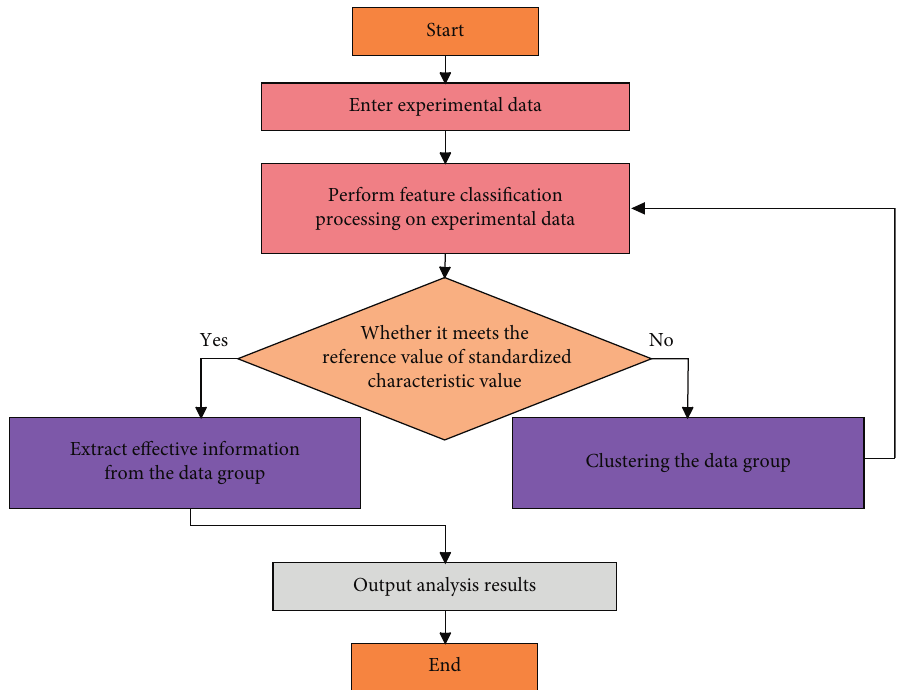
Figure 7: Data processing and analysis process during the experiment.